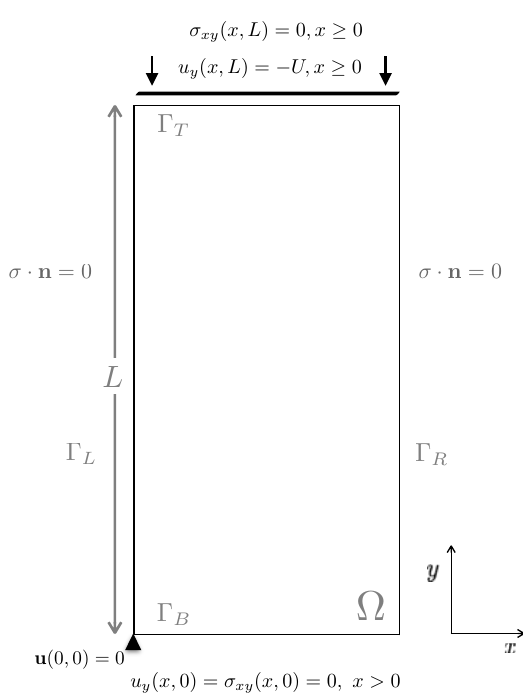
Figure 4. Domain and boundary conditions for the uniaxial com- pression